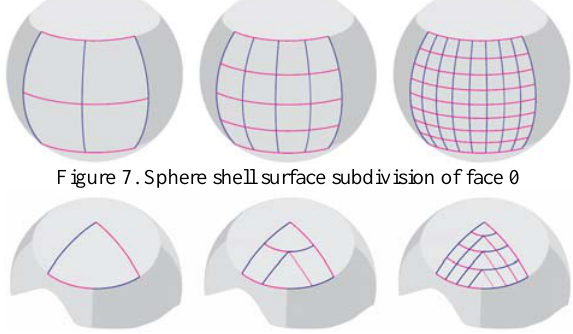
Figure 8. Sphere shell surface subdivision of face 4 The partition curve is extended from sphere surface to spheroid 3D space. In Finger 9 and 10, the gray fan is the partition curve surfaces.